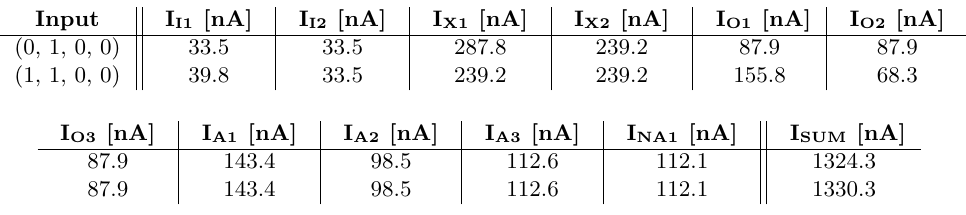
Table 4: Leakage currents exhibited by all circuit gates for the stable inputs before and after the input transition.